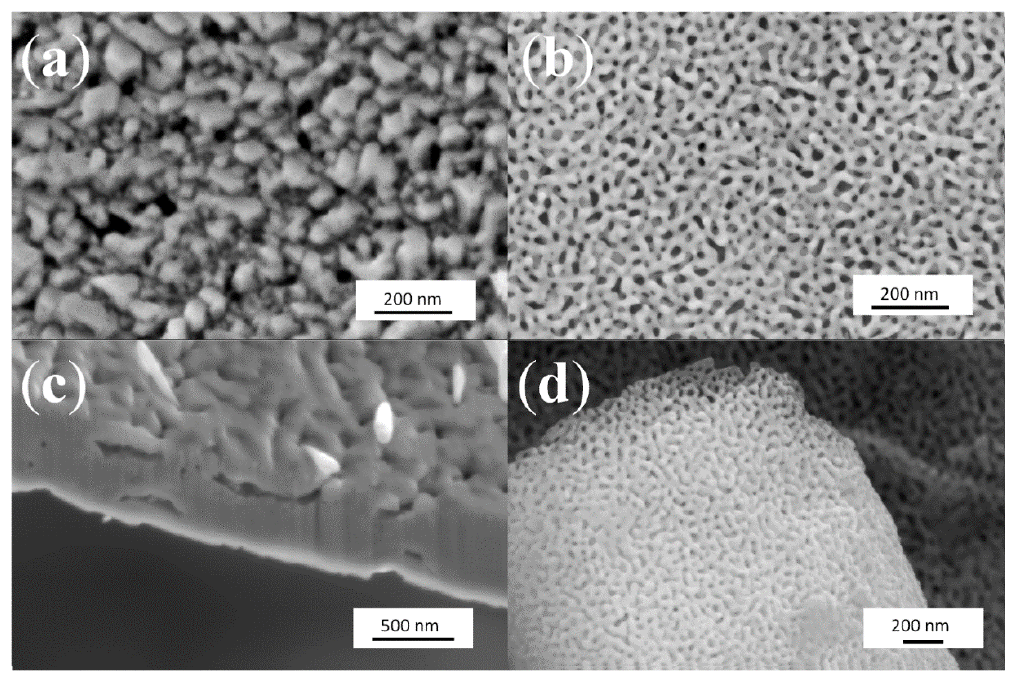
Figure 4. SEM image of de-alloyed CuZn 15 and AuAg 50 : ( a ) DA CuZn 15 with 1 M NaOH for 1 h at room temperature; ( b ) DA AuAg 50 with 70% Nitric Acid for 10 min at room temperature; ( c ) cross-section view of ( a ); and ( d ) cross-section view of ( b